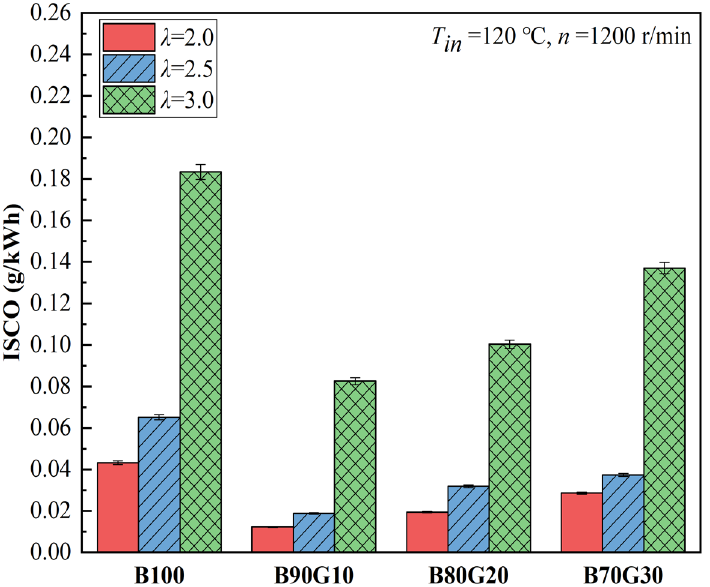
Figure 9. CO emissions with different λ s.